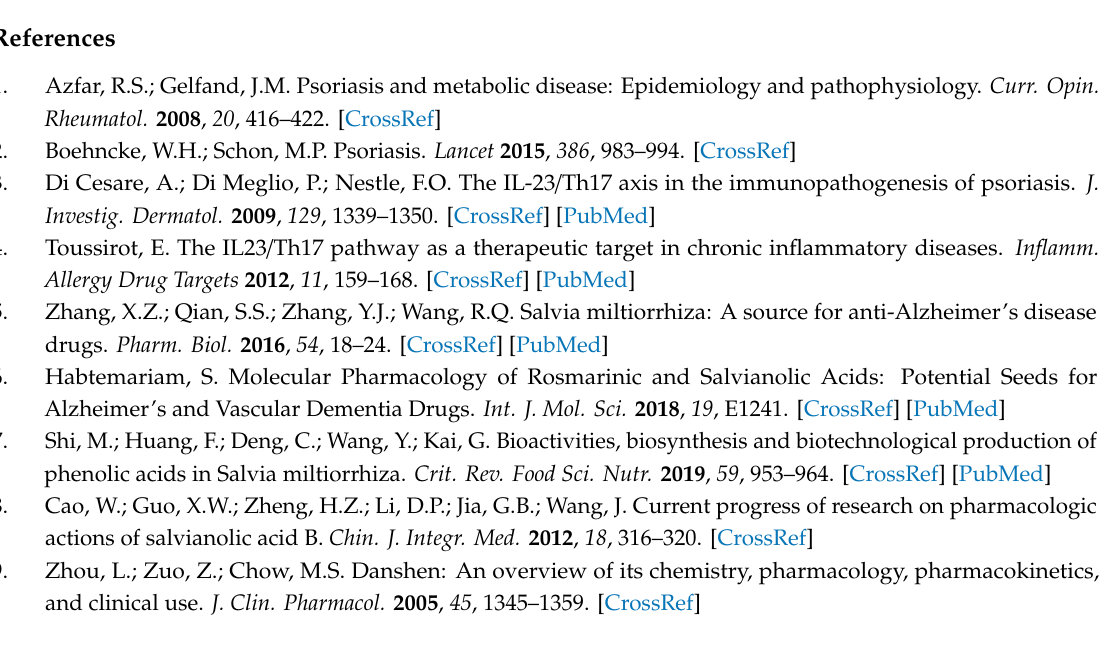
Figure S1: Representative high-performance liquid chromatography of Sal. B and chloramphenicol. (A) blank (B) standard with Sal. B (1 µ g / mL) and internal standard (chloramphenicol) (C) receiver concentration at 1 h after a 200 µ L of Sal. B (300 µ g / mL) was added to the donor cell. The retention time of Sal. B and chloramphenicol (IS) was 6.0 ± 0.1 min and 8.3 ± 0.1 min, respectively. Sal. B, Salvianolic acid B; IS, internal standard, Figure S2: Low dose of Sal. B / formulation A did not improve psoriasis-like dermatitis. The low dosage of Sal. B (100 µ g / mL) in formulation A treatment group showed no significant di ff erence in clinical and pathological features of severity index compare to the control group. Therefore, the 300 µ g / mL Sal. B in formulation A was chosen as the optimal dose for further study. Scale bar = 100 µ m. Brackets indicate thickness of